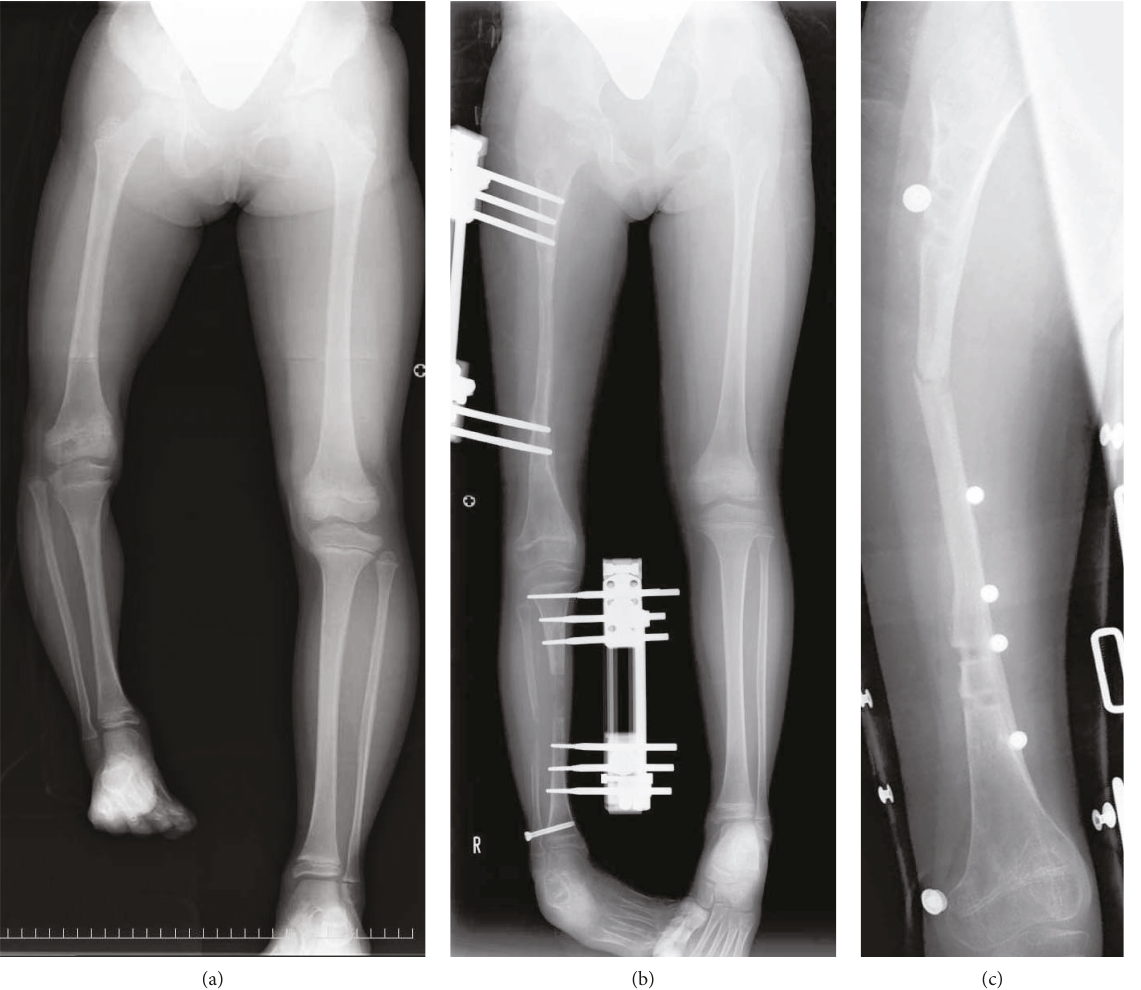
Figure 1: Radiographs of the lower extremities at the time of the fi rst lengthening. (a) An anteroposterior standing radiograph of the lower extremities at seven years of age showing LLD of nearly 10cm with the right foot placed on a block. (b) An anteroposterior supine radiograph of the lower extremities at the end of the lengthening period of the fi rst lengthening demonstrating 83mm and 37mm of lengthening in the femur and tibia, respectively. (c) An anteroposterior radiograph of the right femur showing regenerate fracture at the site of the lengthened